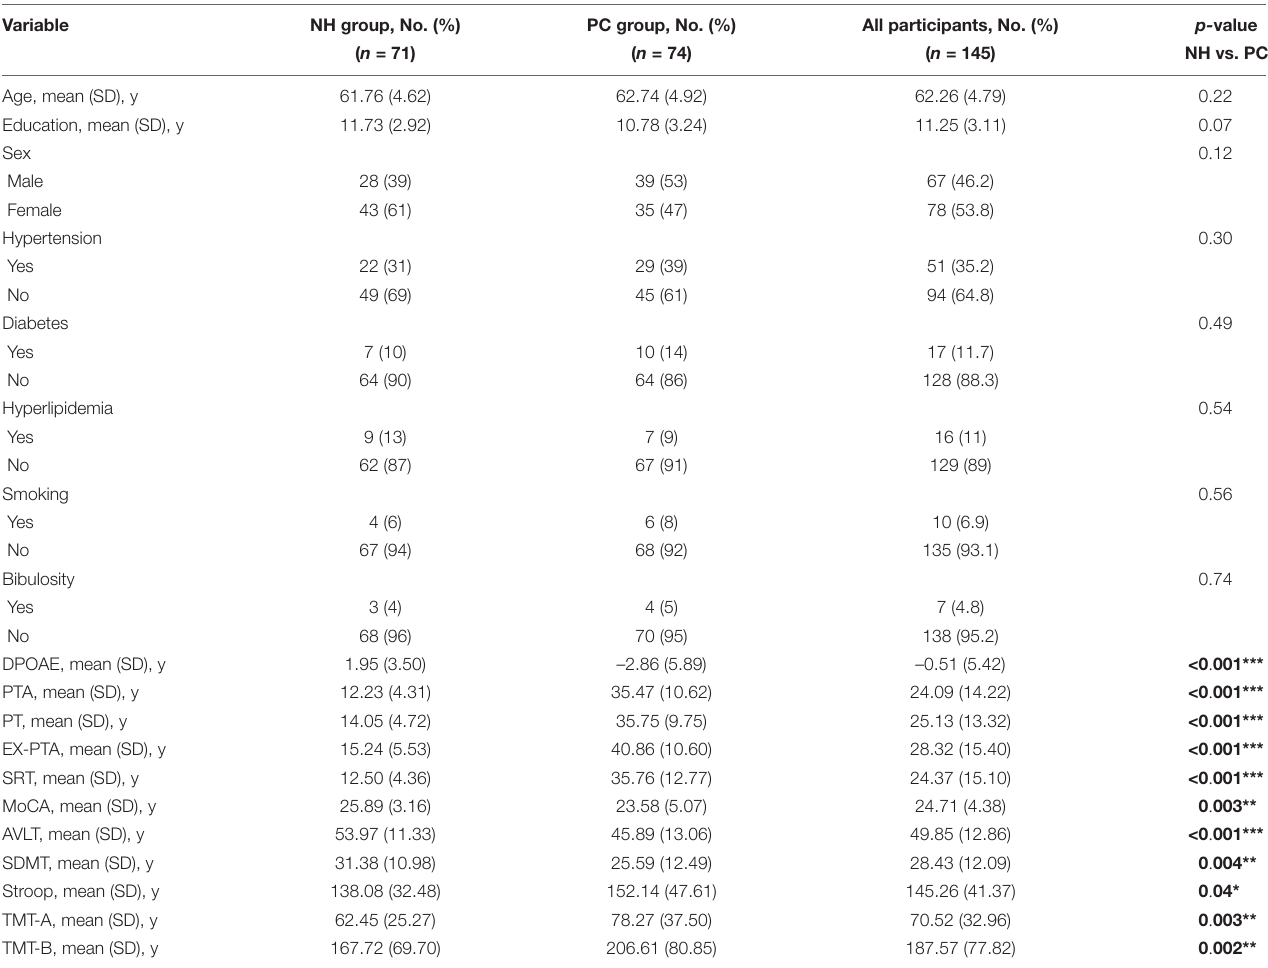
TABLE 1 | Demographics and clinical data of participants.